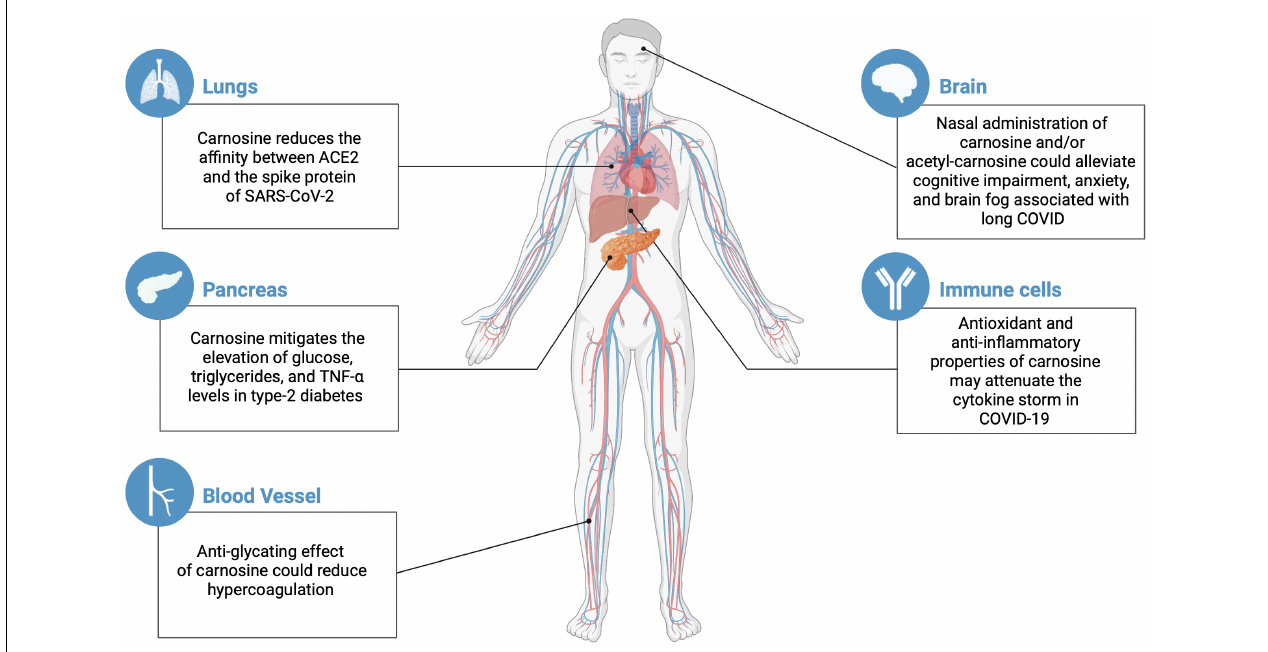
FIGURE 1 | Potential effects of carnosine/acetyl-carnosine on different organs susceptible to COVID and long COVID complications (created with